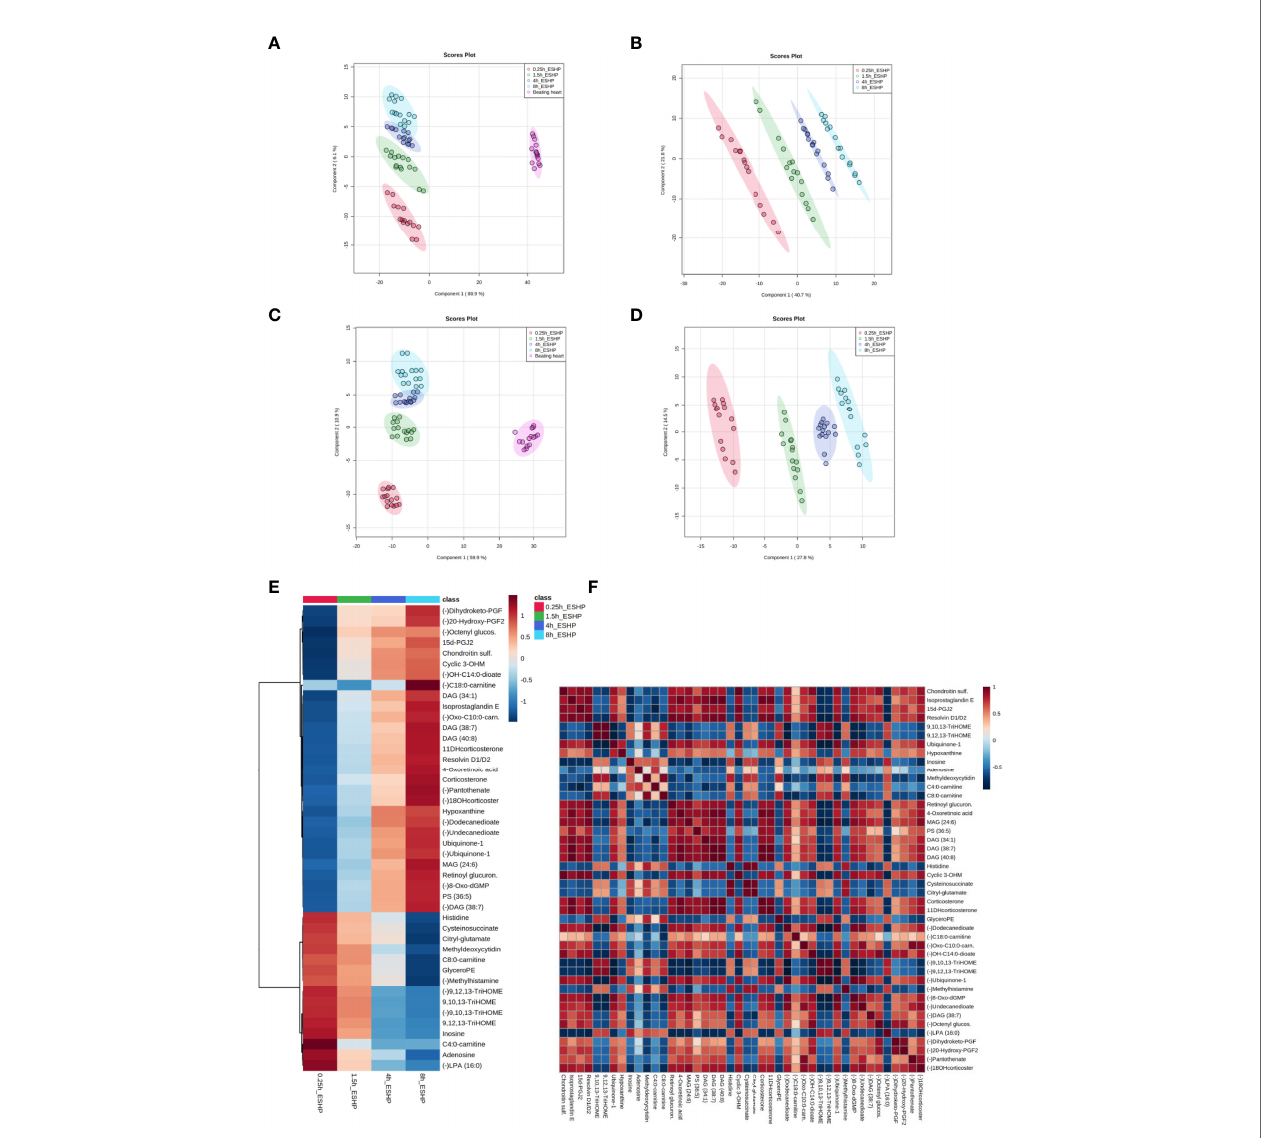
FIGURE 4 | Dynamic changes in metabolomic pattern of ex situ perfused porcine hearts. Partial least square discriminant analysis (PLS-DA) models comparing LC/MS metabolomic pro fi les among fi ve (A, C) and four (B, D) conditions corresponding to relevant sampling time points during in vivo and ex situ heart perfusion, as well as heatmap and correlation analysis for the most discriminative metabolites (E, F) . The presented score plots were created for metabolic features detected in ESI+ (A, B) and ESI- (C , D) /PFP-based mode. The degree of variance (re fl ecting the strength of the constructed model) is shown in parentheses on each axis. The different groups of samples are presented using different colors [each dot represents an individual sample (one biological replicate)]: pink — samples collected in vivo (from beating heart); red — samples collected 15 min after commencing ESHP; green — samples collected 1.5 h after commencing ESHP; dark blue — samples collected 4 h after commencing ESHP; light blue — samples collected 8 h after commencing ESHP. Circles represent 95% con fi dence intervals. Additionally, the robustness of the PLS-DA models was validated via leave-one-out cross-validation (LOOCV) and calculating relevant Q2 and R2 values. The 5-component cross-validation measures for R2Xcum of 0.998 (ESHP/ESI+) and 0.998 (ESHP/ESI-), and the Q2cum values of 0.997 (ESHP/ESI+) and 0.995 (ESHP/ESI-) are excellent and provide good fi t to the data and high predictive ability. (E) Heatmap analysis highlighting metabolites/lipid species showing the largest change in cardiac tissue between 15 min and 8 h of ex situ heart perfusion. (F) Correlation plot showing signi fi cant correlations between cardiac metabolite levels altered throughout ESHP (Pearson ’ s R). ( – ) refers to negative ionization mode. The labels on the x and y- axis on the heatmaps are frequently presented as abbreviations (due to limited space). Dihydroketo-PGF2 – 8-iso-13,14-dihydro-15-keto-PGF2a; 20-Hydroxy-PGF2 – 20- Hydroxy-PGF2a; Octenyl glucos. – 1-Octen-3-yl glucoside; 15d-PGJ2 – 15-Deoxy-d-12,14-PGJ2; cyclic 3OHM – Cyclic 3-Hydroxymelatonin; OH-C14:0-dioate – 3- Hydroxytetradecanedioic acid; C18:0-carnitine – Stearoylcarnitine; Oxo-C10:0-carn – 6-Keto-decanoylcarnitine; 11-DHcorticosterone – 11-Dehydrocorticosterone;